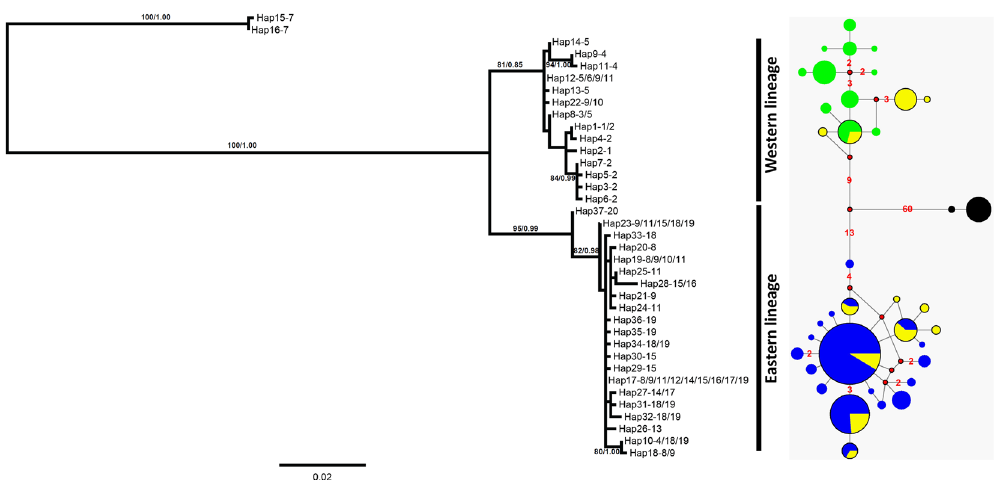
Figure 2. Maximum likelihood (ML) tree and the median-joining network derived from cytochrome b partial sequences of B . tibetanus sampled in the Qinling Mountains. The haplotypes are named by numbers (1–37). Haplotype shared by multiple locations are labelled by all location numbers separated by ‘/’. Haplotype and location numbers are separated by ‘ − ’. The two haplotypes (Hap15 and Hap16) from QLC population are the Tibetan lineage of B . tibetanus distributed in the Qinling Mountains (Supplementary Fig. S1), and are considered to be outgroup to explore phylogenetic relationship among the Qinling lineages. The Qinling lineages were previously described as B . taibaiensis 35 . Numbers next to nodes of ML tree indicate bootstrap values and Bayesian posterior probabilities. Numbers in network represent the mutation steps. Sizes of circles are proportional to the haplotype frequencies. Colours for populations: green, the western group; blue, the eastern group; yellow, populations possessing haplotypes from both lineages; black, the QLC